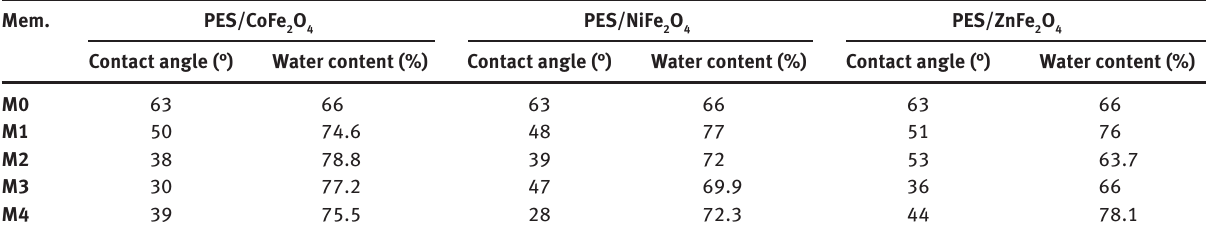
Table 2: Contact angle and water content of all fabricated membranes